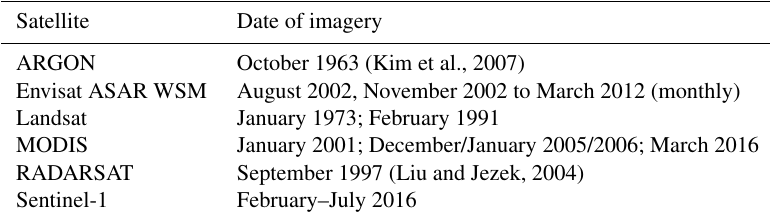
Table 1. Satellite imagery used in the study